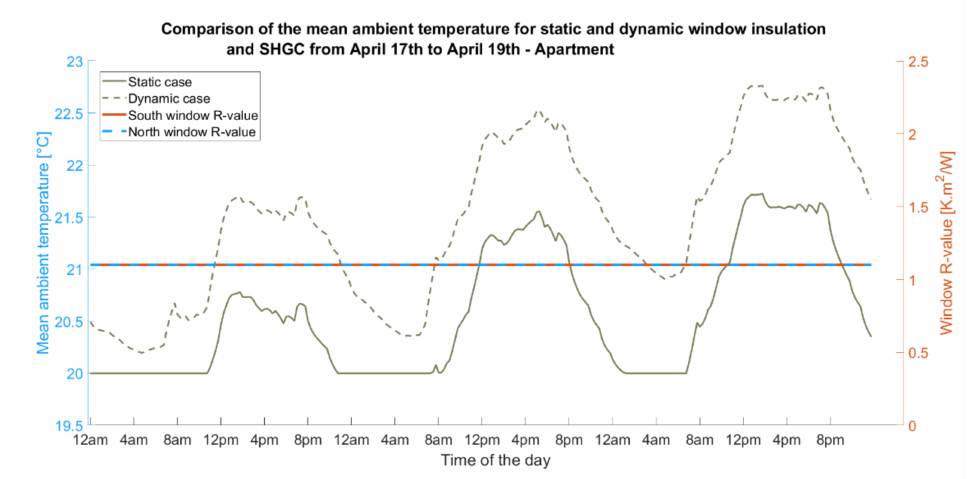
Figure 5. Indoor air temperature variations for static and dynamic windows during 17 April to 19 April for the apartment unit. For dynamic windows, high R-value = 1.1 m 2 · K/W; low R-value = 0.45 m 2 · K/W; high SHGC = 0.4; low SHGC = 0.1. For static windows, R-value = 0.45 m 2 · K/W; SHGC = 0.4.